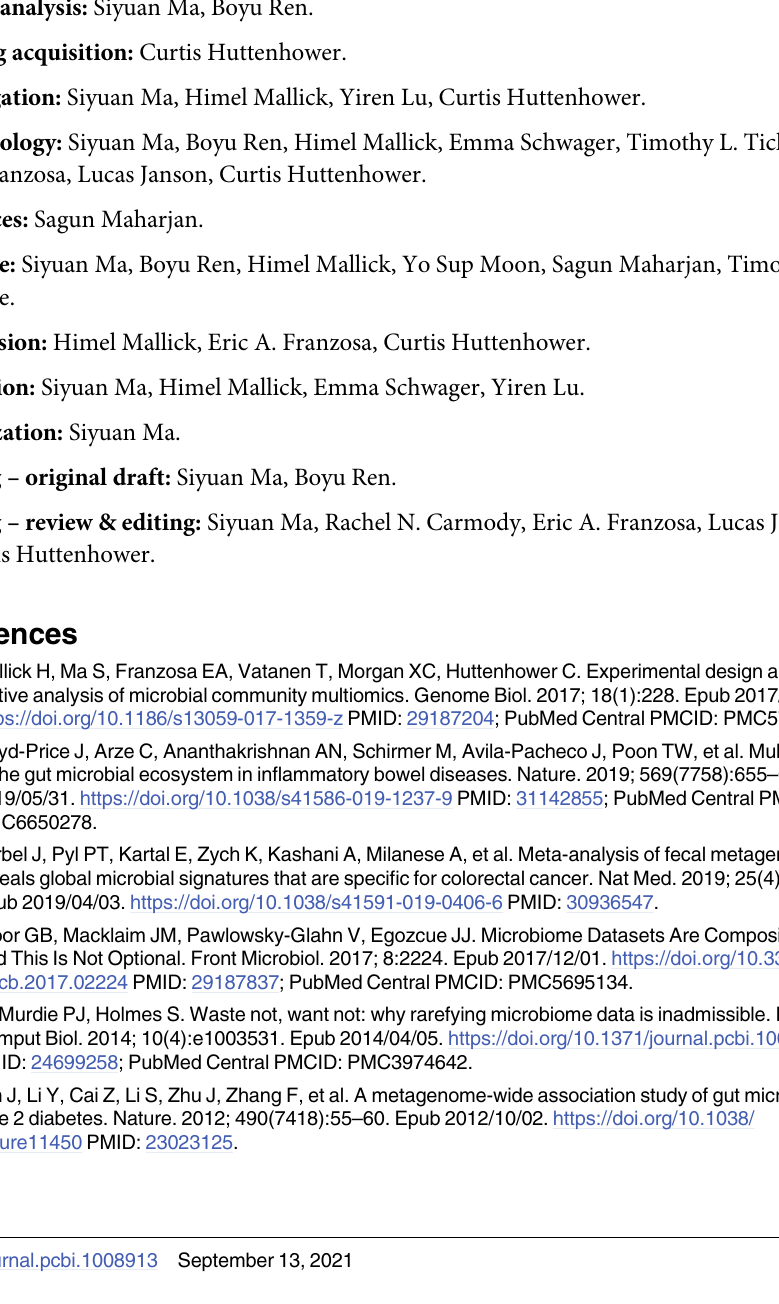
S3 Table. Wilcoxon rank sum test p-values for the difference of R 2 statistics comparing SparseDOSSA 2 against the two existing methods (corresponding to Fig 2B). S4 Table. Wilcoxon signed rank test p-values for the difference of Kolmogorov-Smirnoff statistics comparing SparseDOSSA 2 against the two existing methods (corresponding to Fig 2D).